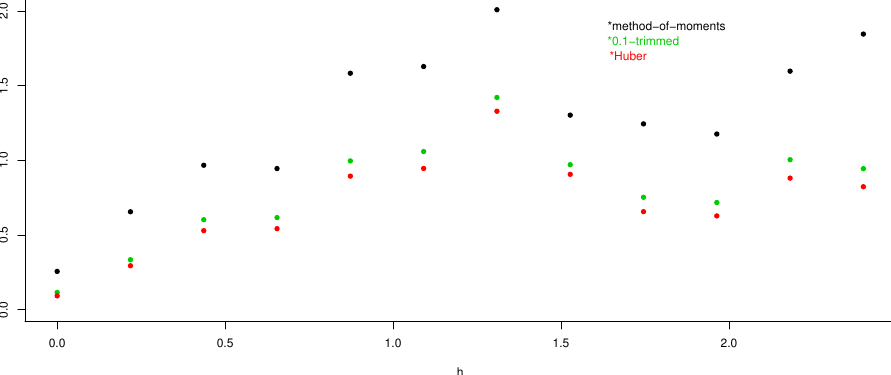
Figure 6. Classical (black) and robust (green and red) cross-variogram estimations of Example 2. Assuming as underlying model, a scale contaminated normal with (cid:101) = 0.01 and g = 1.1, the linearized versions of the variograms for the logarithm of Lead are shown in Figure 7. The linearized versions of the variograms for Nickel are shown in Figure 8. Finally, the linearized versions for the cross-variograms models are shown in Figure 9.